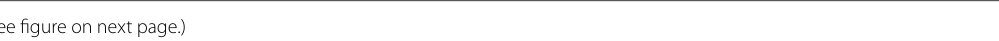
10 min. The profiles below each top row spectrum show the extracted spectra of the five rhamnolipid groups with RL1 645.3;